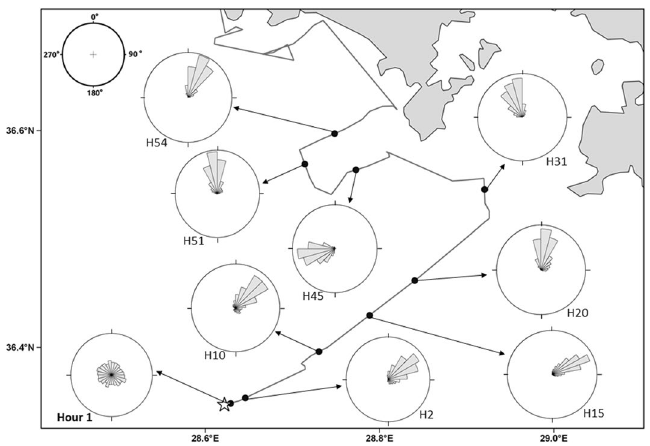
Figure 2. Distributions of magnetic headings recorded in hourly samples along turtle’s E route. The star indicates the release site.